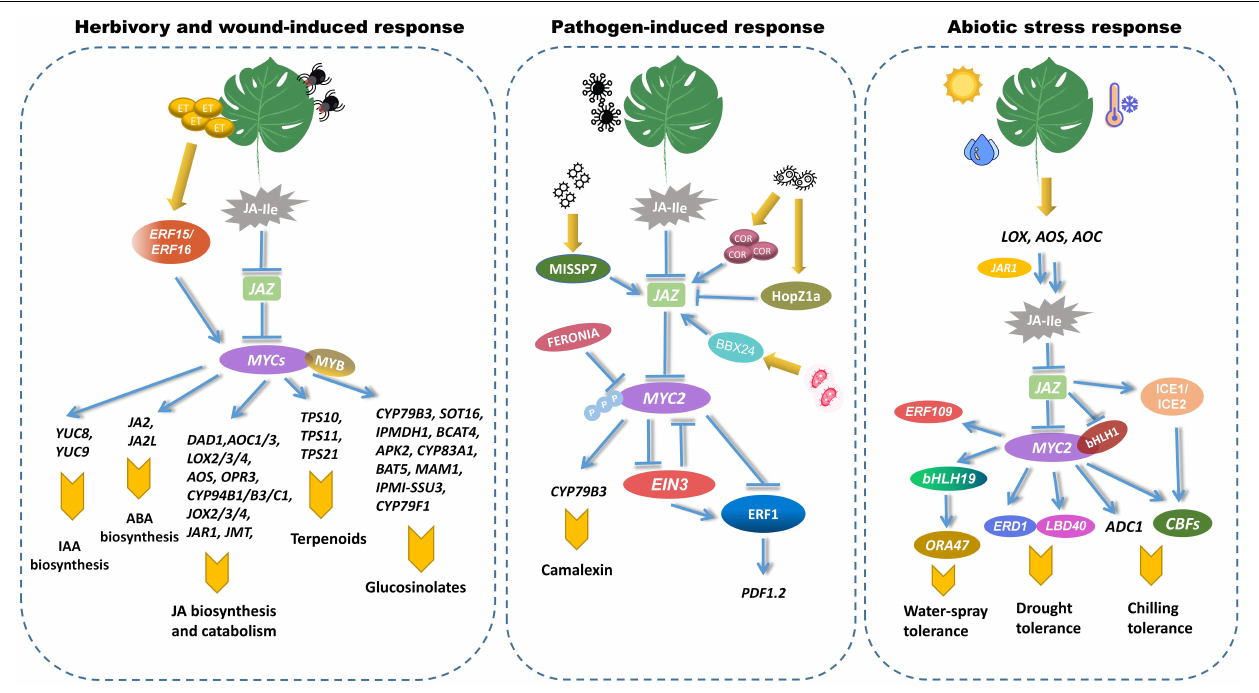
FIGURE 4 | MYCs regulate biotic and abiotic stress responses in plants. MYCs participate in the process of pathogen infection and wound responses. MYCs interact with MYB to control the expression of several glucosinolate-biosynthetic genes, such as CYP79B3 , SOT16 , IPMDH1 , and BCAT4, etc. (Mikkelsen et al., 2003; Piotrowski et al., 2004; Knill et al., 2008; He et al., 2011). MYC2 promotes the production of terpenoid phytolexin by upregulating the expression of TPS10, TPS11, and TPS21 (Hong et al., 2012). MYC2 regulates the associated mechanical injury of herbivorous insects by positively regulating the expression of NAC019 and JA2L , which increase the expression level of VSP1 and TD (Du et al., 2014, 2017). MYC2 enhanced the transcription of the IAA biosynthesis genes YUC8 and YUC9 (Pérez-Alonso et al., 2021). The transcription of multiple JA biosynthesis and catabolism genes are also mediated by MYC2 under wounding response. MYC2 interacts with EIN3 in ethylene signaling to antagonistically regulate the expression of ERF , which in turn regulates the expression of pathogen-related PDF1.2 (Song et al., 2014). MiSSP7 and BBX24 inhibit MYC2-targeted gene expression by increasing their interaction with JAZ (Daguerre et al., 2020; Zhang H. et al., 2020). HopZ1a triggered AtJAZ1 degradation and increased the expression of JA-responsive genes (Jiang et al., 2013). MYC2 function is inhibited by FER via its phosphorylation (Guo et al., 2018). MYCs are engaged in abiotic stresses such as low temperature, water-spray and drought. Environmental stress can increase the transcription of MYC2 and bHLH1 , which in turn upregulate the expression of low-temperature stress-related CBFs and drought stress-related ERD1 (Li Y. et al., 2019; Wang Y. et al., 2019). ICE1 and ICE2 upregulate the expression of CBFs (Kashyap and Deswal, 2019). MYC2 increased ADC1 levels, which resulted in increased putrescine biosynthesis (Ding et al., 2021). Water spray-inducible MYC-regulon creates a hierarchical transcriptional network via interacting with bHLH19 and ERF109 (van Moerkercke et al., 2019). bHLH19 in turn directly activates the promoter of ORA47 (Chen et al.,